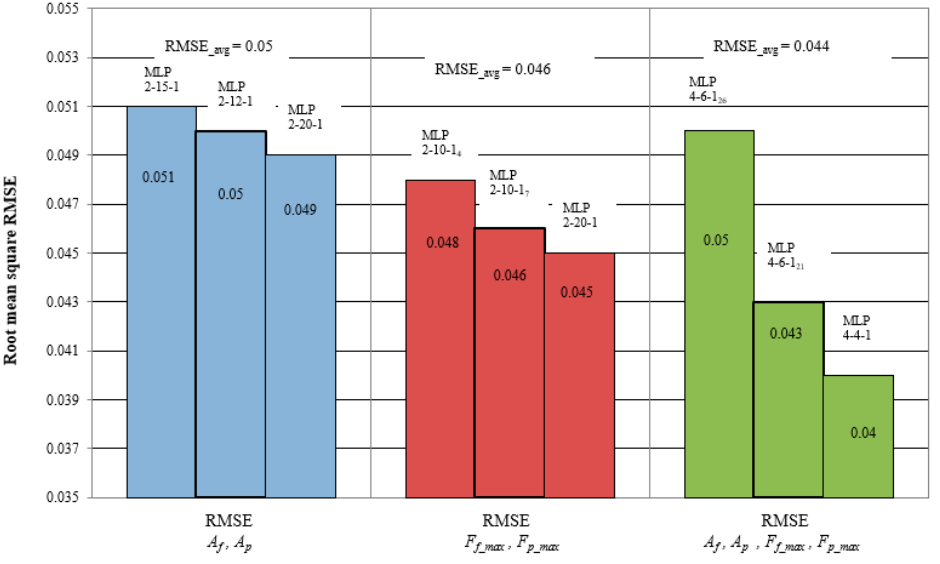
Figure 14. Comparison of RMS errors of the neural networks used in the validation stage.